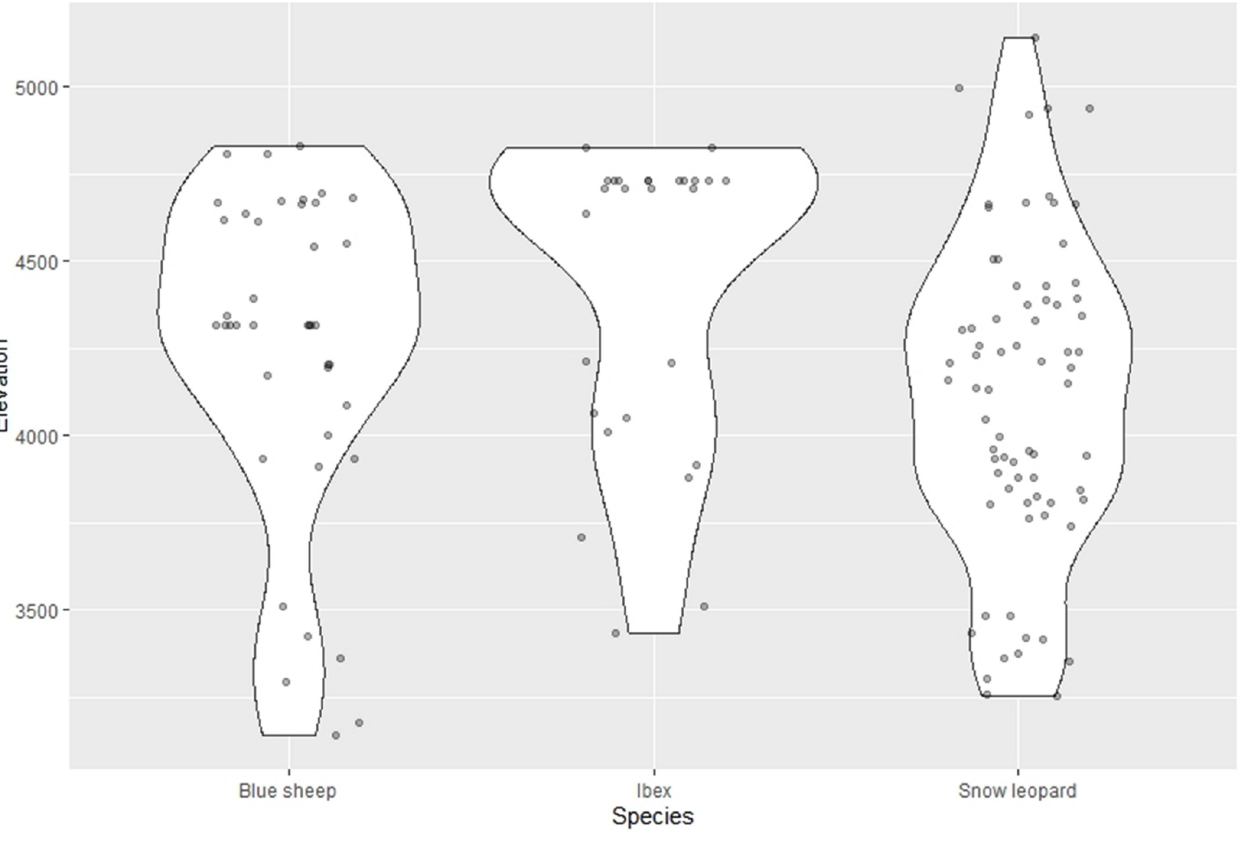
Fig 2. Violin plot displaying the elevational distribution over which snow leopard and its prey species were detected.